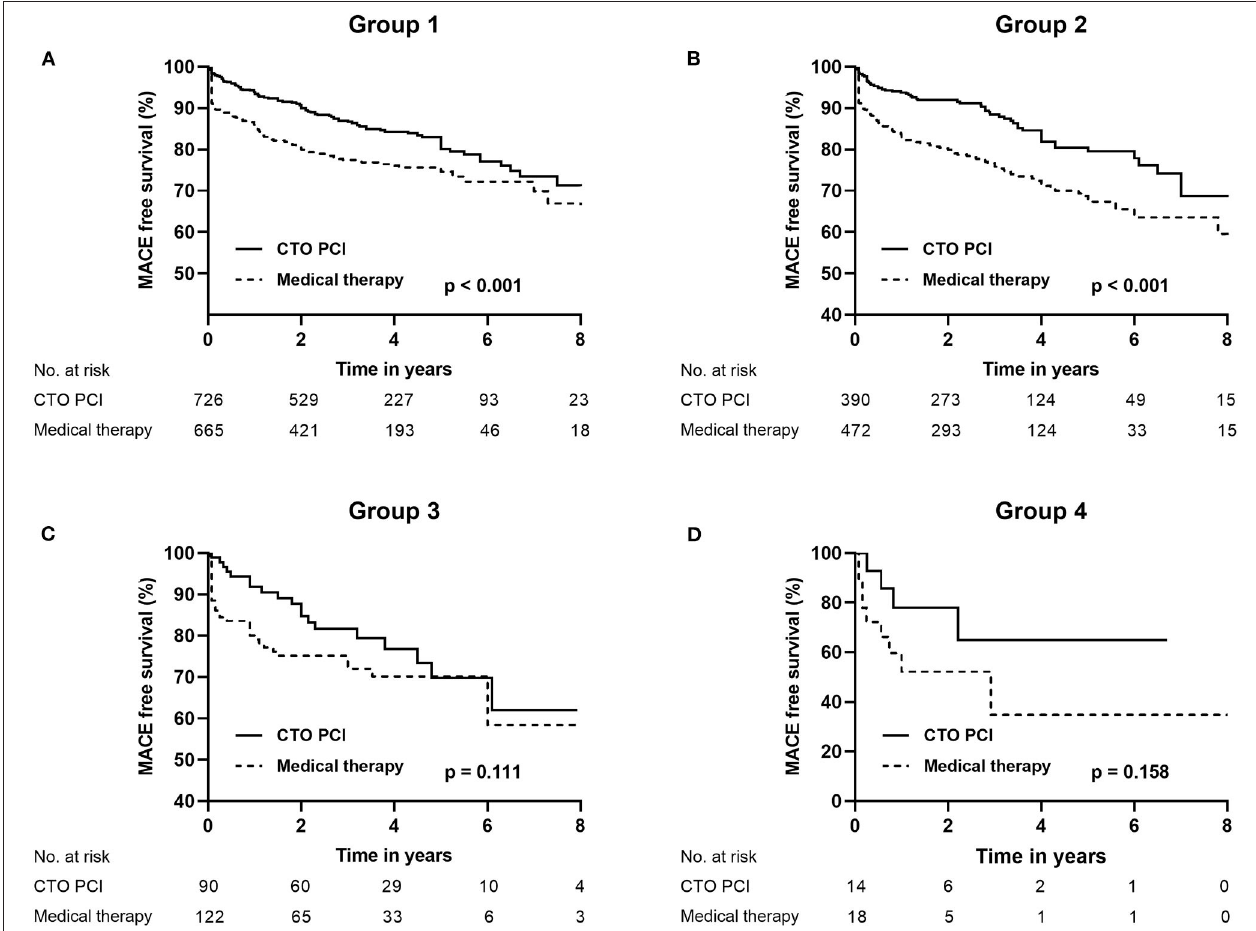
FIGURE 2 | Kaplan–Meier curves for MACE (A–D) during follow-up for CTO PCI vs. medical therapy in CTO patients according to baseline renal function (groups 1, 2, 3, and 4). CTO, chronic total occlusion; MACE, major adverse cardiovascular events; PCI, percutaneous coronary intervention; Group 1 [estimated glomerular filtration rate (eGFR) ≥ 90 ml/min/1.73 m 2 ]; Group 2 (60 ≤ eGFR < 90 ml/min/1.73 m 2 ); Group 3 (30 ≤ eGFR < 60 ml/min/1.73 m 2 ); Group 4 (eGFR < 30 ml/min/1.73 m 2 ).